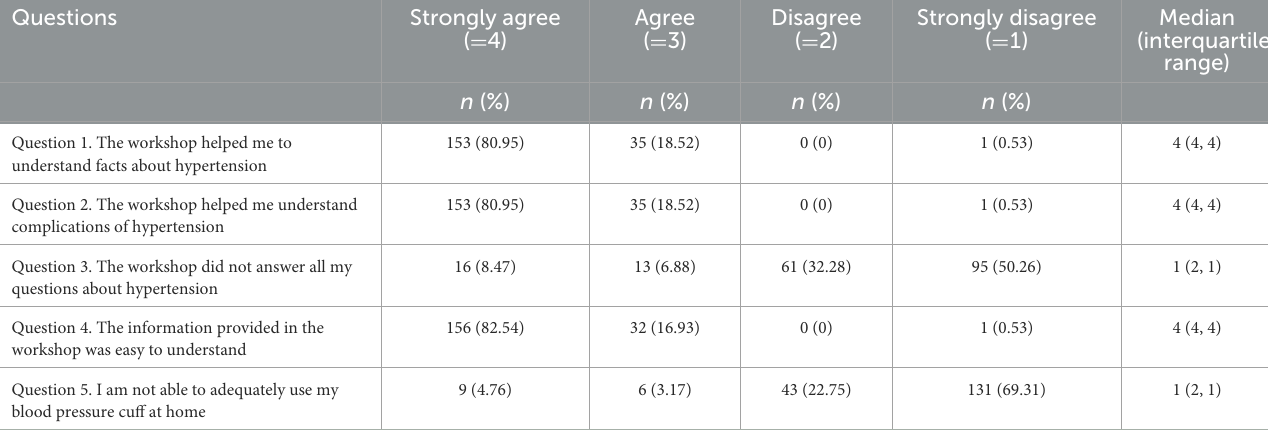
TABLE 5 Participant experience survey data ( n =